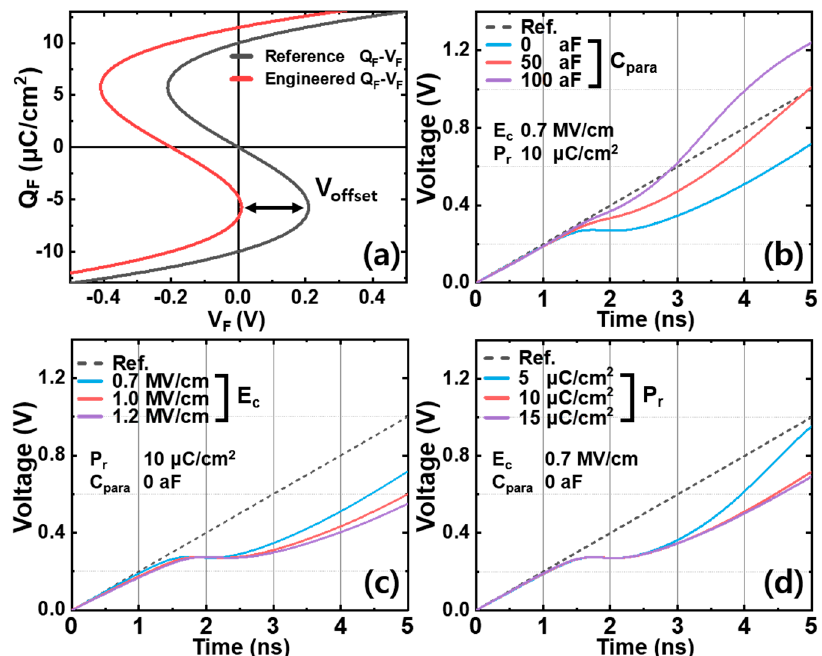
Figure 2. ( a ) Two S-curves are drawn in polarization versus voltage plot. The red-colored one is the S-curve with work function engineering. The black-colored one is the reference S-curve, for comparison. Note that P r and E c of the reference S-curve are 10 µ C / cm 2 and 0.7 MV / cm, respectively. V INT -vs.-time for ( b ) various parasitic capacitances, ( c ) E c , and ( d ) P r . Note that the reference line (black-colored dotted line) indicates the 100 MHz 1 V triangular pulse.